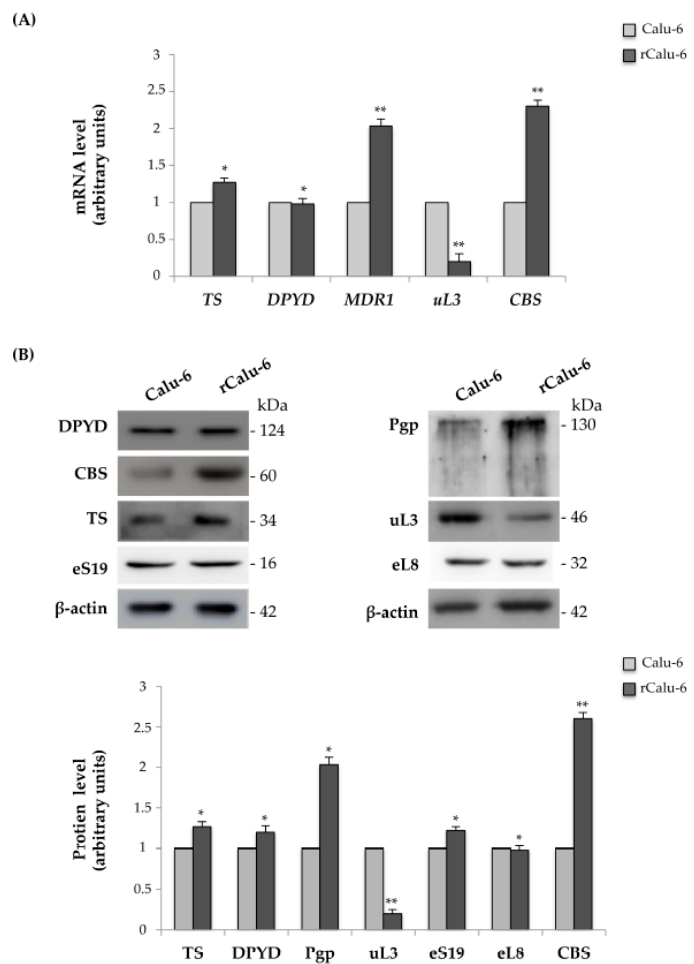
Figure 2. Analysis of mRNAs and proteins related to chemoresistance. ( A ) Total RNA from Calu-6 and rCalu-6 cells was subjected to Reverse Transcription quantitative Polymerase Chain Reaction (RT-qPCR) with primers specific for the indicated mRNAs. The quantification of signals is shown. ** p < 0.01, * p < 0.05 vs. mRNA levels in Calu 6 cells set at 1; ( B ) Protein extracts from Calu-6 and rCalu-6 cells were analyzed by Western blotting with antibodies against the indicated proteins. β -actin was used as the loading control. The quantification of signals is shown. ** p < 0.01, * p < 0.05 vs. protein levels in Calu 6 cells set at 1.